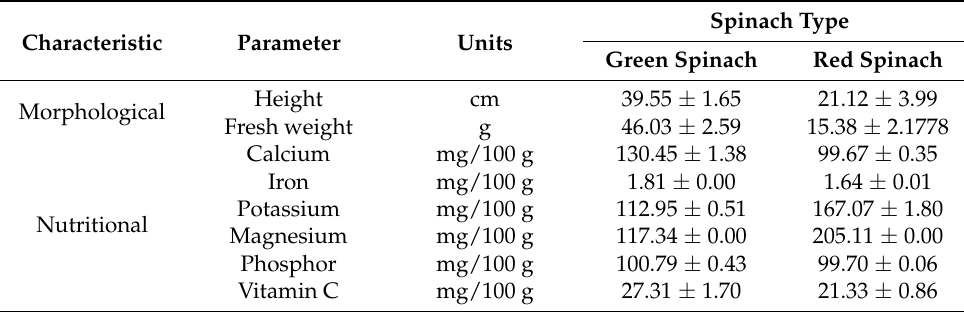
Table 1. Morphological and nutritional characteristics of green and red